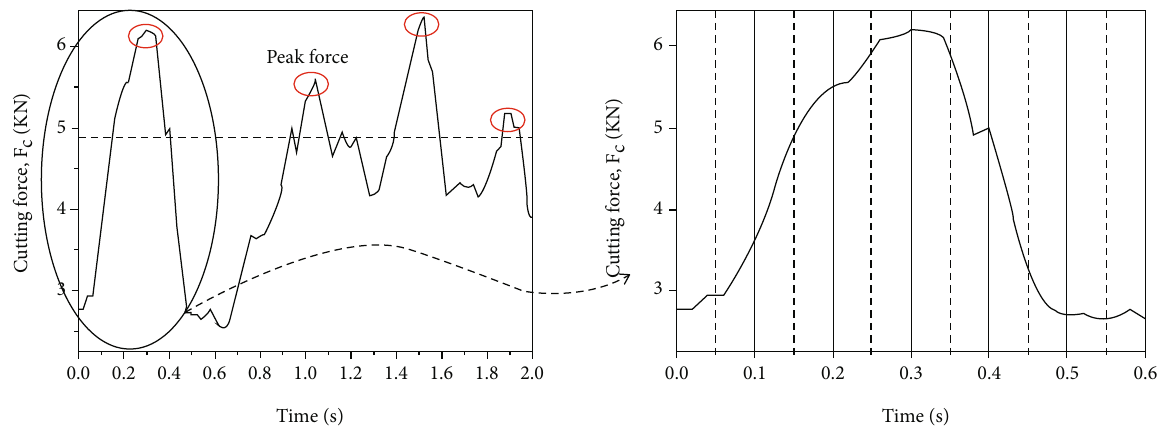
Figure 1: The typical cutting force curve of